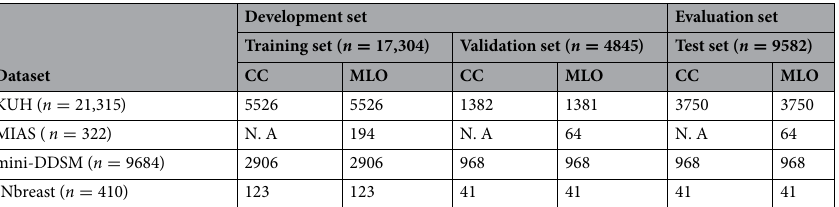
Table 1. The splitting protocol used in this study. We employed a 60:20:20 splitting protocol for training, validation, and evaluation sets for the MIAS, INbreast, and mini-DDSM datasets. Note that the splitting protocol for the KUH dataset is different than the public datasets. N.A not available.